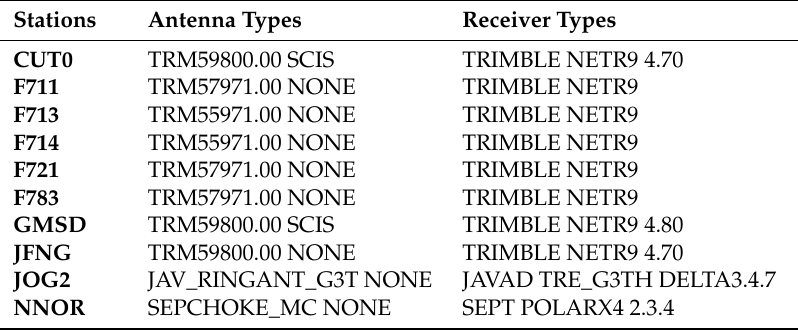
Figure 1. The distribution of the GNSS stations. Table 1. The types of antennas and receivers equipped at the GNSS stations.